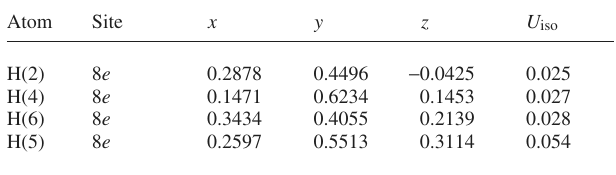
Table 2. Atomic coordinates and displacement parameters (in Å 2 )